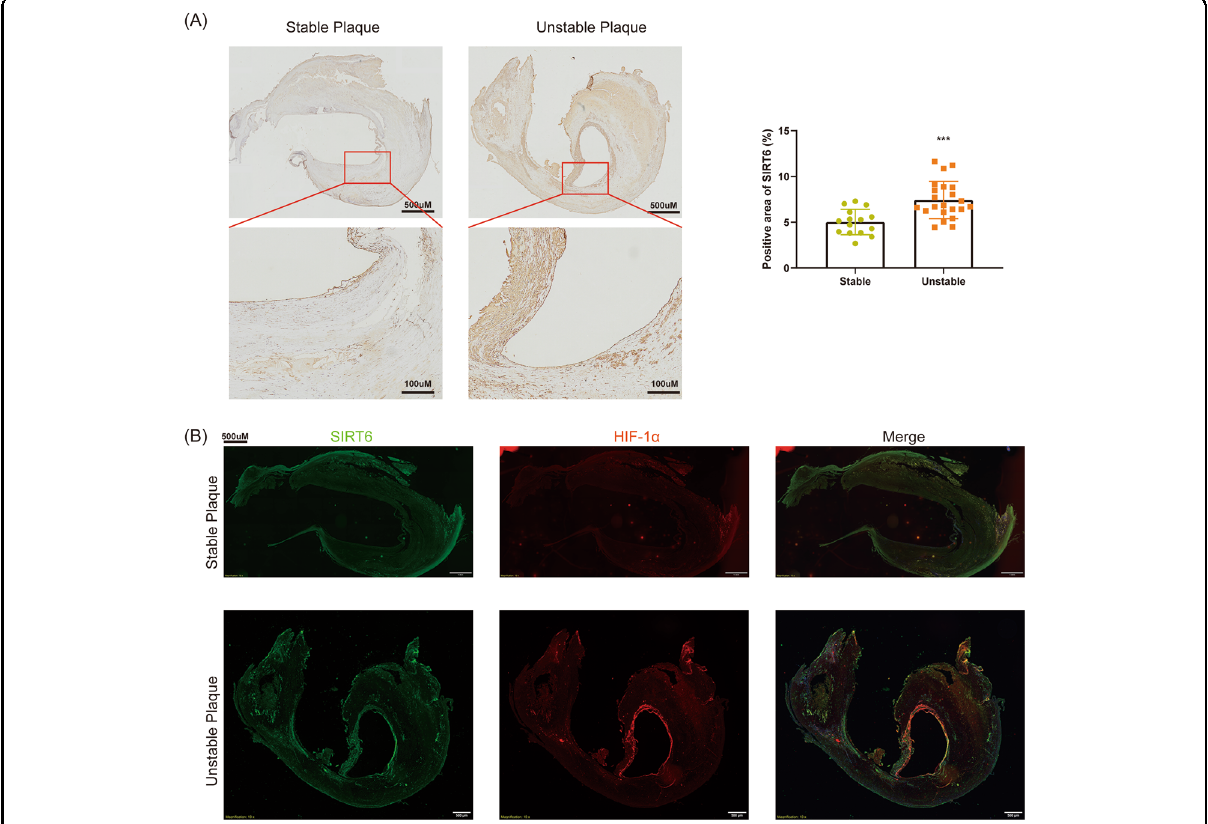
Fig. 1 SIRT6 was overexpressed in unstable carotid plaque accompanied by co-location of HIF-1 α . A IHC of SIRT6 in stable ( n = 14) and unstable carotid plaques ( n = 22). B Co-location of SIRT6 and HIF-1 α in stable and unstable carotid plaques (*** P <